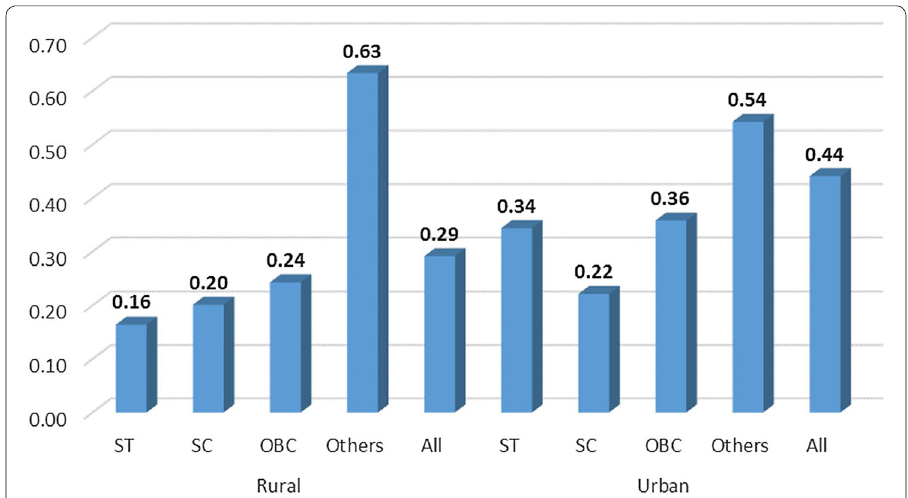
Table 7 Distribution of employed population (PS